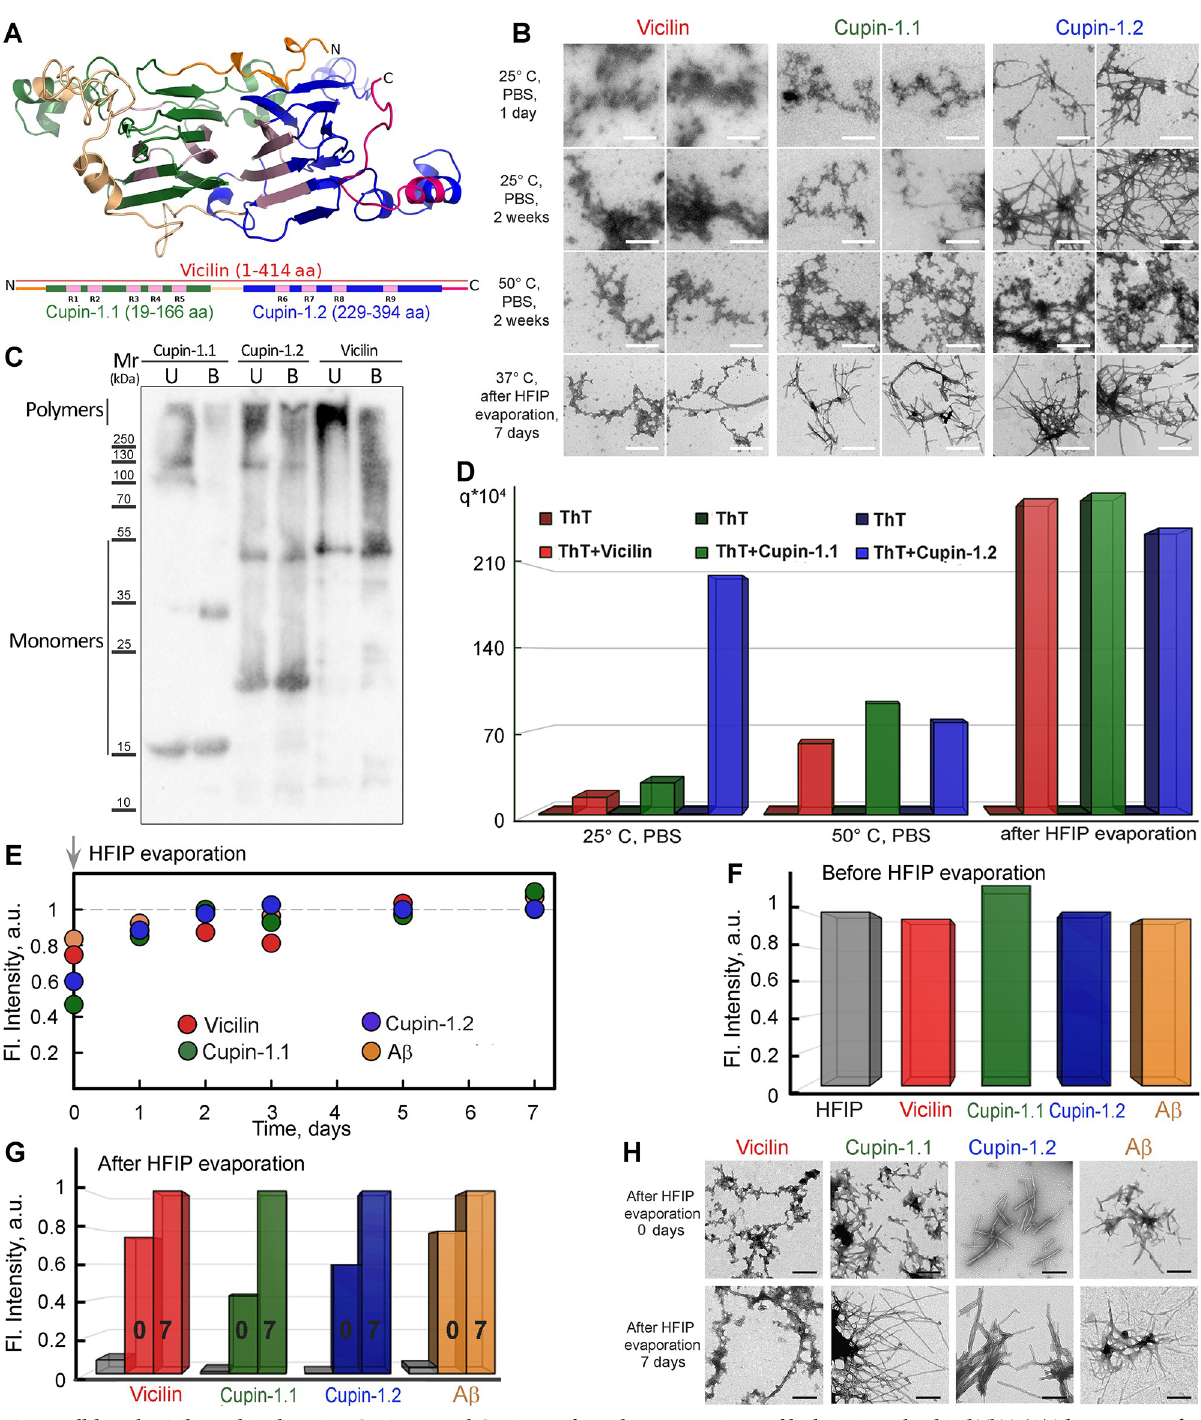
Fig 1. Full-length Vicilin and its domains, Cupin-1.1 and Cupin-1.2, form detergent-resistant fibrils in vitro that bind ThT. (A) The structure of the Vicilin monomer has been predicted by the I-TASSER server [30]. The domain structure of Vicilin is presented below with bars. The Cupin-1.1 domain is denoted by green, Cupin-1.2 with blue, and full-length Vicilin with red. The linkers are colored with ochre, light yellow, and magenta. N- and C-termini are shown. Predicted by AmylPred2 [31], amyloidogenic regions are indicated as R1–R9 and highlighted in pink. (B) TEM of the aggregates obtained in various conditions: in 5 mM PBS (row 1), with prolonged incubation (row 2) and temperature increase (row 3) as well as after dissolution in 50% HFIP followed by fibrillogenesis in water (row 4). The scale bars correspond to 500 nm. (C) The resistance of the Vicilin, Cupin-1.1, and Cupin-1.2 aggregates to treatment with cold (U, unboiled) and hot (B, boiled) 2% SDS. Molecular weights (kDa) are shown. (D) Fluorescence